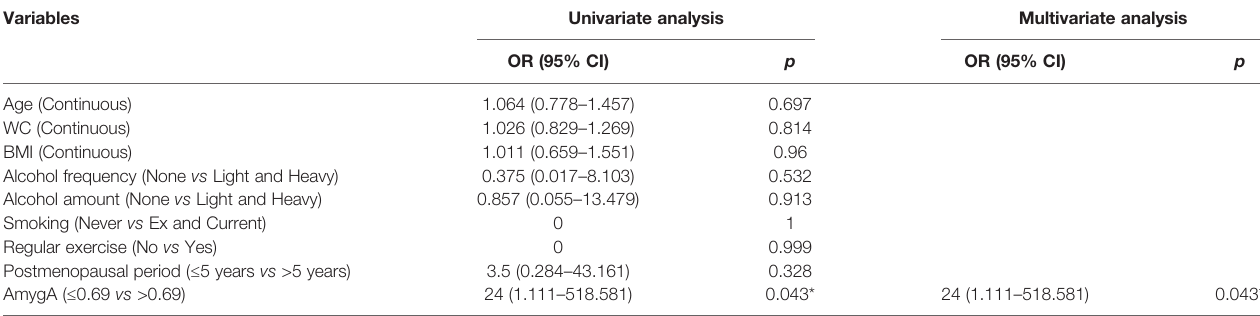
TABLE 6 | Uni- and multivariate logistic regression analyses for the associated predictors of osteoporosis in postmenopausal women with high risk of stress.